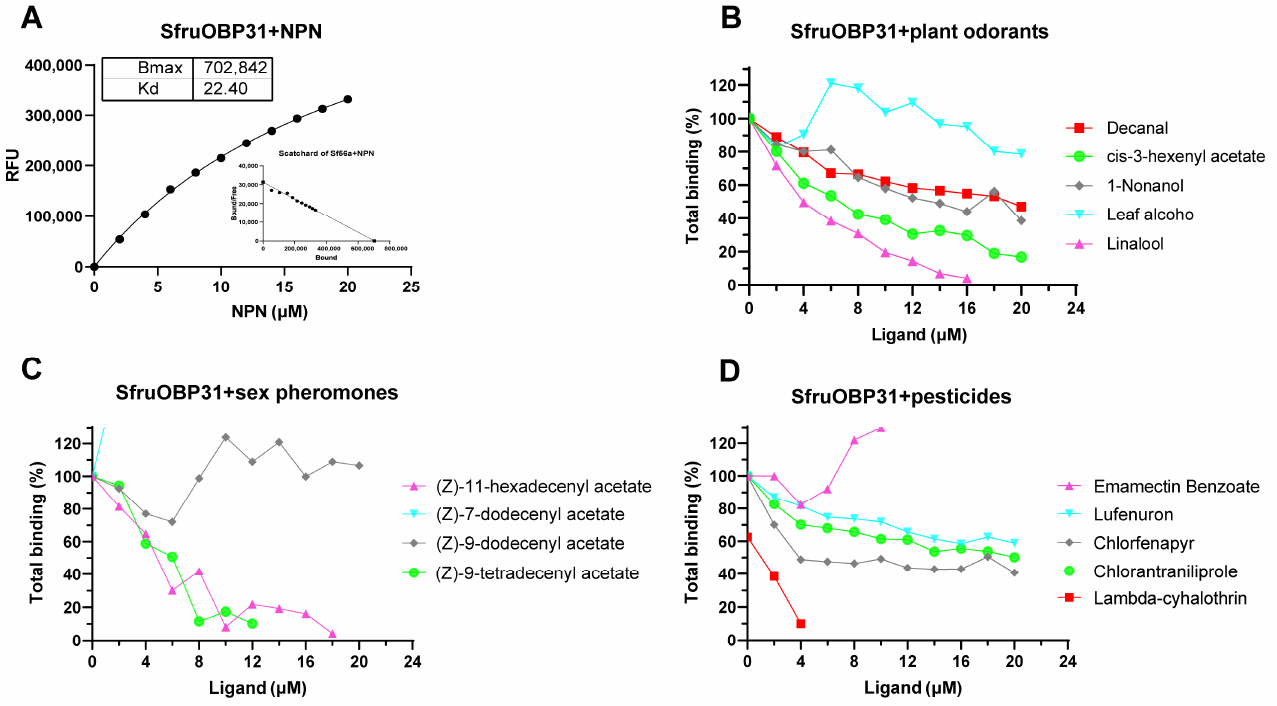
Figure 11. Binding assays of SfruOBP 31 testing volatiles from host plants, pheromones, and pesticides. ( A ) Binding curves and dissociation constants of SfruOBP31 with 1 ‐ NPN. ( B ) Competitive binding curves of SfruOBP31 with five host volatiles. ( C ) Competitive binding curves of SfruOBP31 with four pheromones. ( D ) Competitive binding curves of SfruOBP31 with five pesticides.